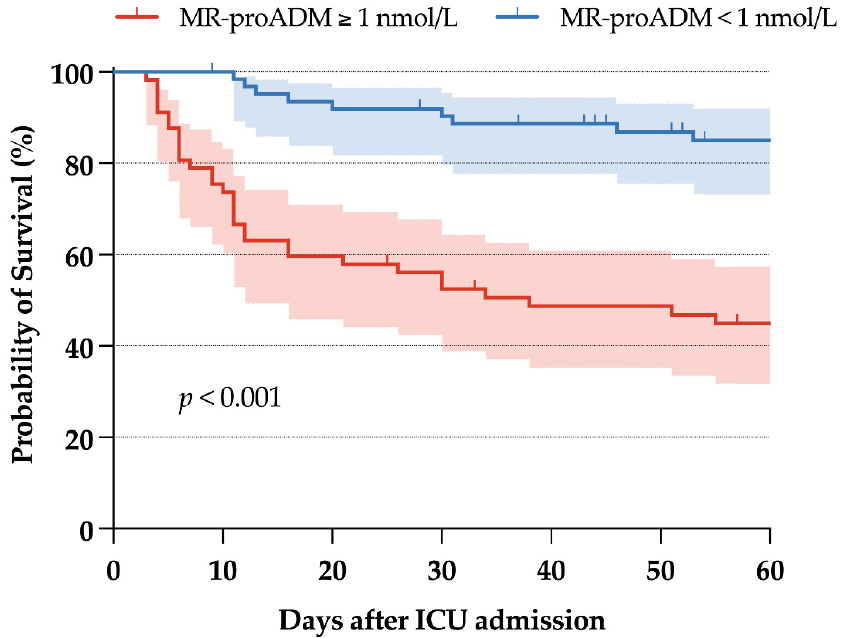
Figure 2. Survival curves according to a cut-point of 1 nmol/L of MR-proADM on day 1.